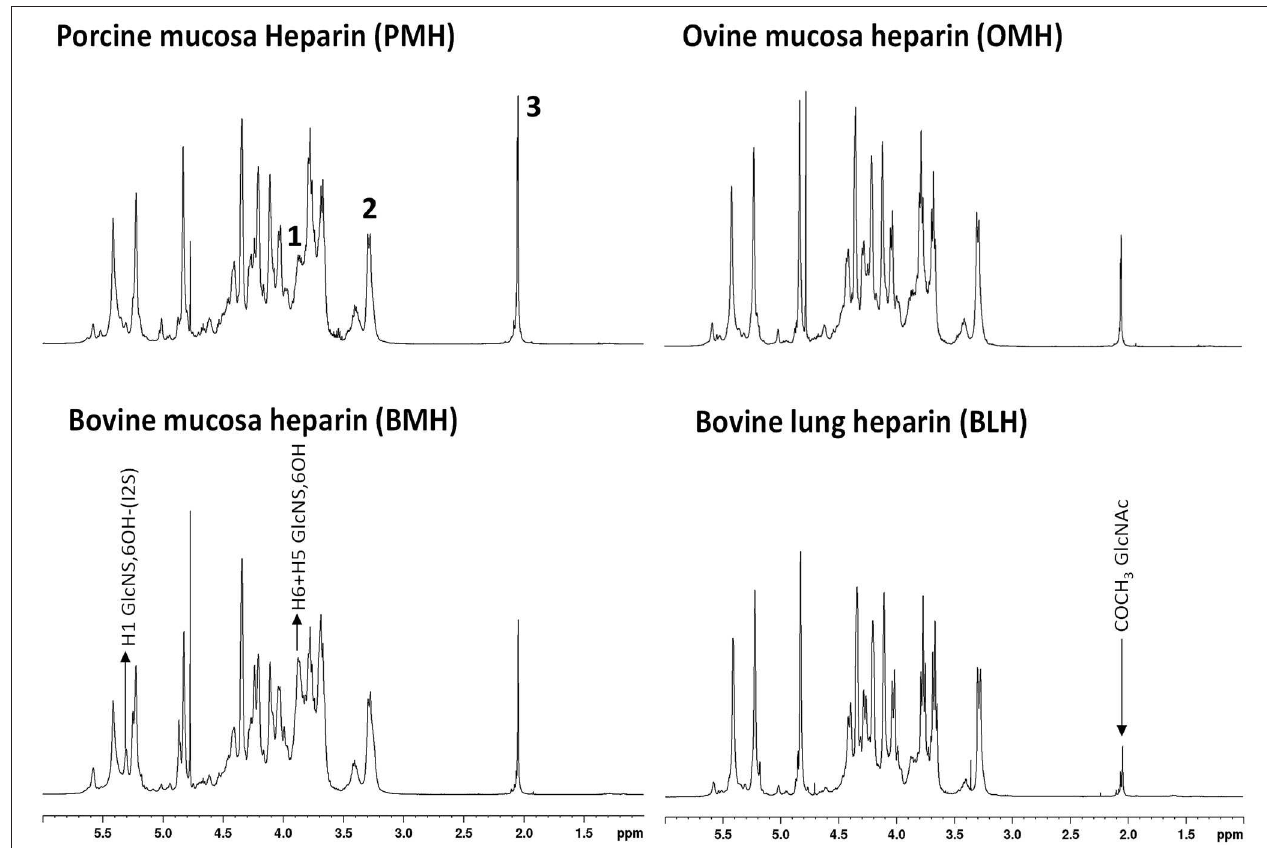
FIGURE 1 | 600 MHz proton spectra of heparin samples extracted from different species/organ. Signals 1, 2, and 3, corresponding to H5 + H6 of 6- O -desulfated glucosamine, H2 of N -sulfated glucosamine, and acetyl group of N -acetylated glucosamine, respectively, were used as diagnostic peaks for the determination of the